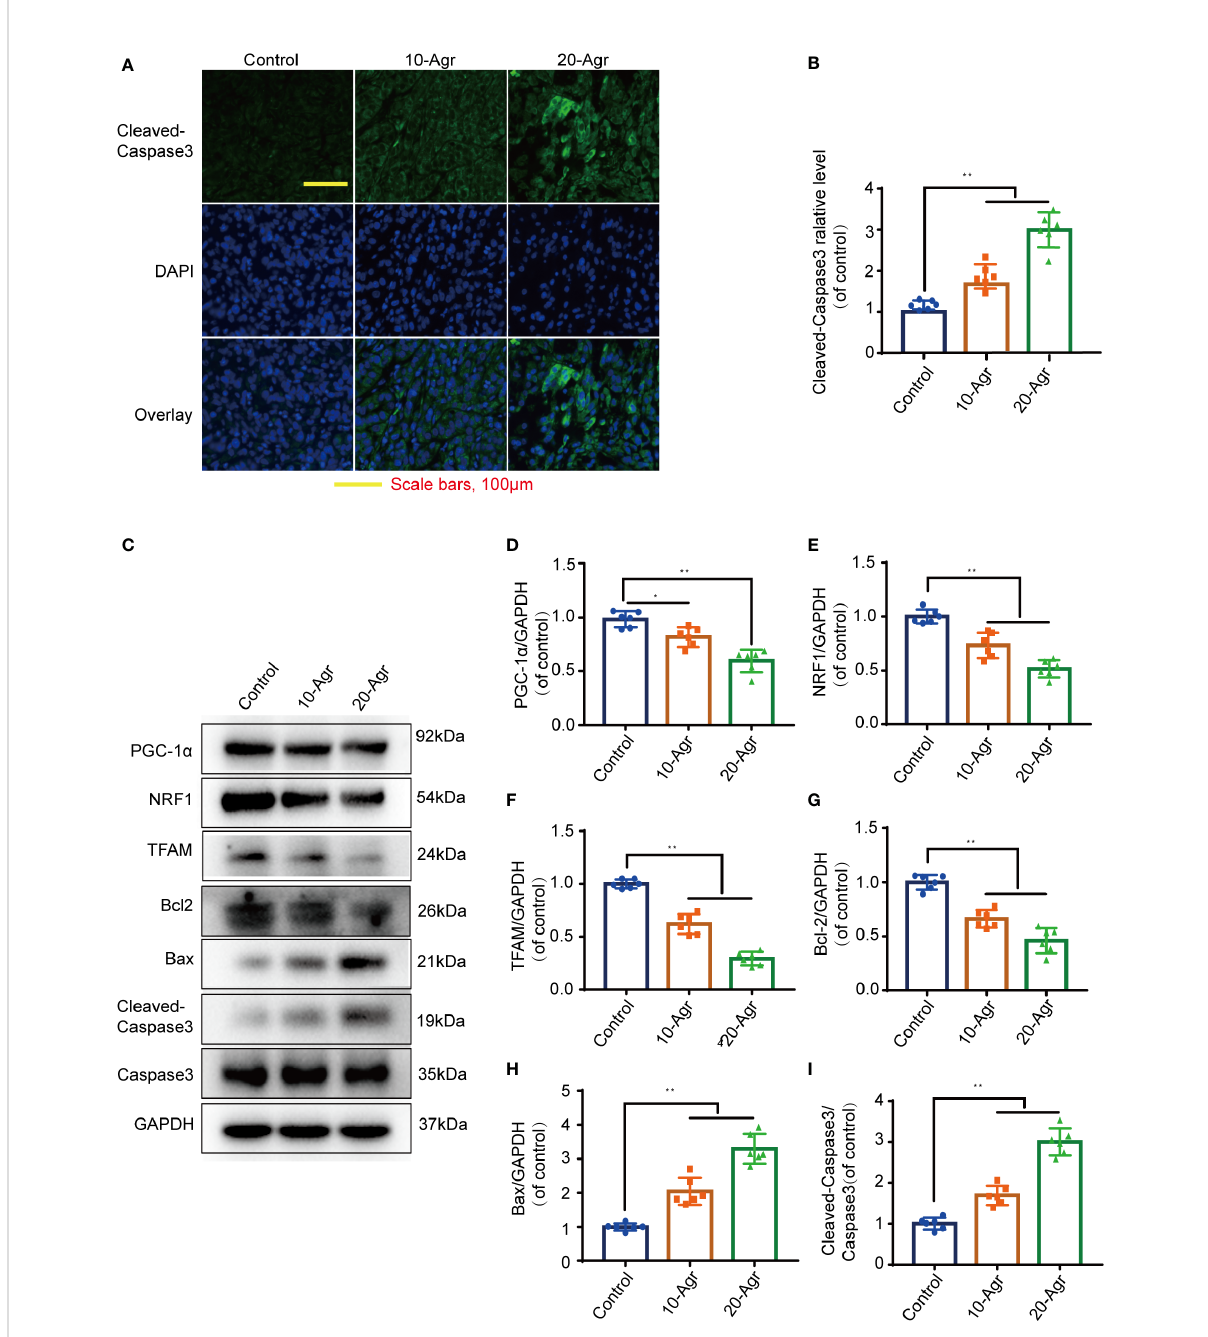
FIGURE 7 Agr decreased PGC-1 a activation and NRF1 and TFAM expression in tumor tissue. 10-Agr represents Agr 10 mg/kg (i.p., QD), 20-Agr represents Agr 20 mg/kg (i.p., QD), and 5-FU represents 5-FU 5 mg/kg (i.p., QD). (A) Confocal fl uorescence images of tumor tissue with Cleaved-Caspase- 3 staining. Nuclei in blue (DAPI); antibody protein in green (Cleaved-Caspase-3). Scale bars, 100 m m. (B) Quantitative data for the relative Cleaved-Caspase-3 levels in a confocal fl uorescence assay ( n = 6). (C) The levels of TFAM, PGC-1 a , NRF1, Cleaved-Caspase-3, Bcl-2, Caspase- 3, and Bax were analyzed in the tumor tissue by Western blotting analysis ( n = 3). (D – H) Quantitative data for the ratios of PGC-1 a , NRF1, TFAM, Bcl-2, and Bax to internal control protein (GAPDH) in tumor tissue. (I) Quantitative data for the ratio of Cleaved-Caspase-3 to Caspase-3. * p